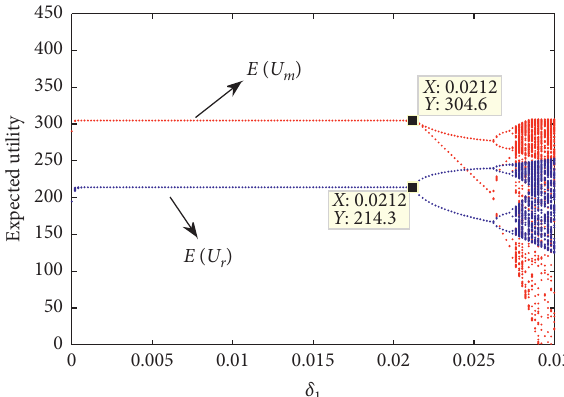
Figure 13: The expected utility of dynamic system (15) with δ